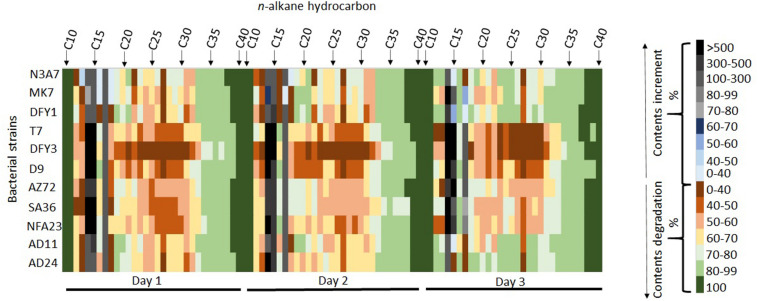
Heatmap showing degradation and increment of hydrocarbon contents during incubation. The percentage of hydrocarbon degradation and increment is represented by the different color scales on the right.